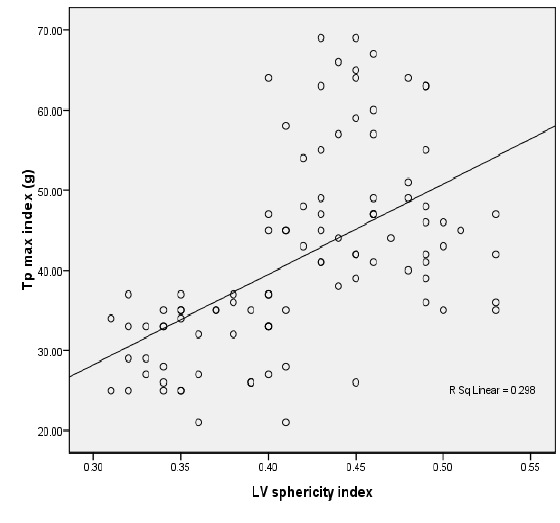
Figure 2) : correlation between LV dyssynchrony ( T-P max) and LV massindex